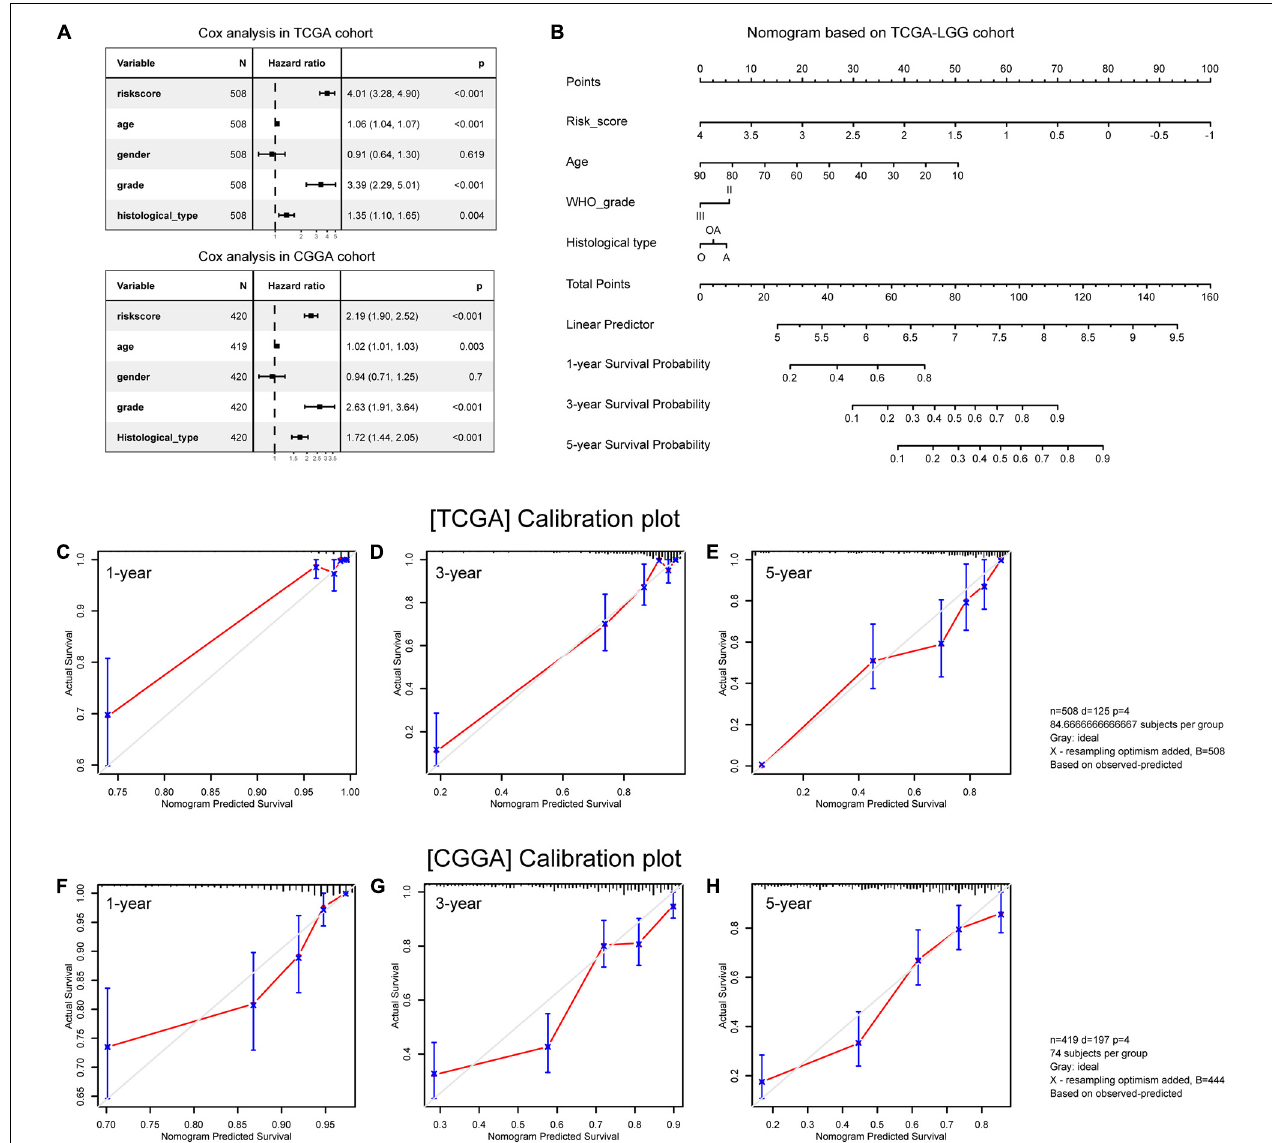
FIGURE 9 | Construction and validation of the nomogram. (A) Multivariate analysis results. (B) Nomogram based on risk score, age, WHO grade, and histological type. (C–E) Calibration plots of the nomogram for predicting the probability of OS at 1-, 3-, and 5-year in the TCGA cohort. (F–H) Calibration plots of the nomogram for predicting the probability of OS at 1-, 3-, and 5-year in the CGGA cohort. A, astrocytoma; O, oligodendroglioma; OA,